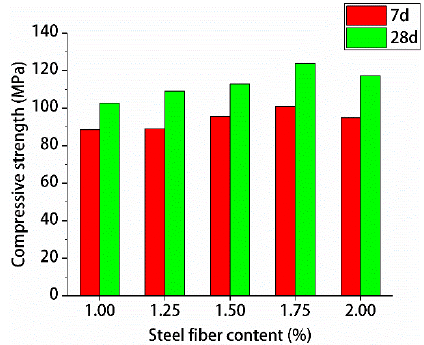
Figure 13. Test results for compressive